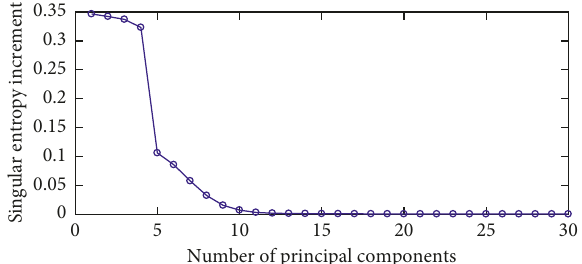
Figure 6: Singular entropy increments of principal components.